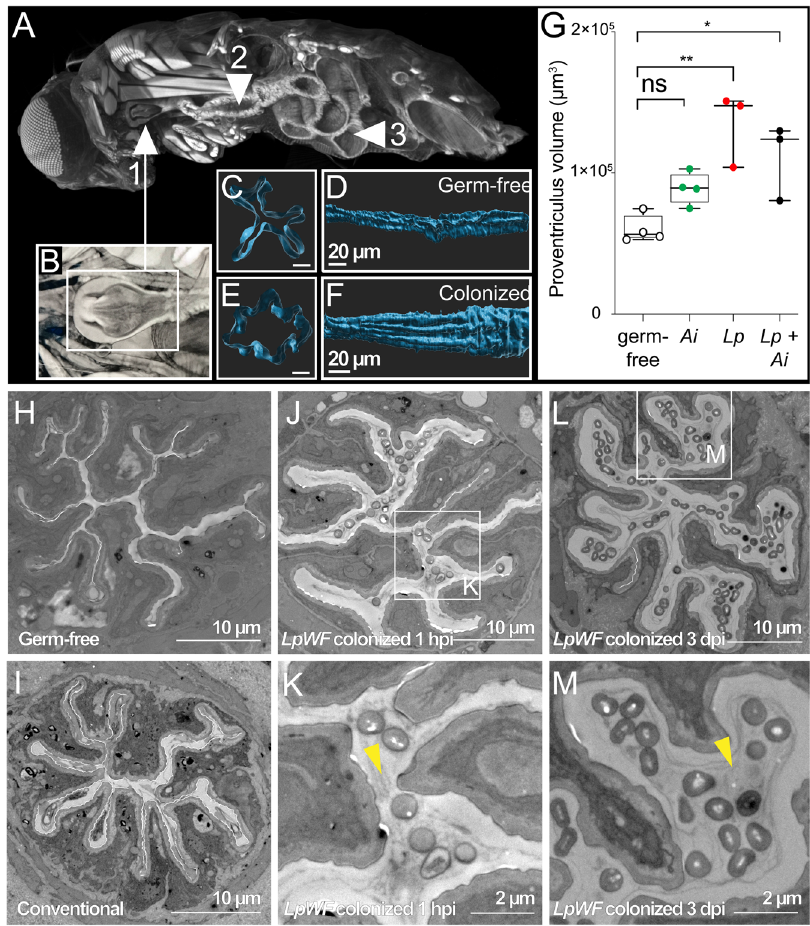
Fig. 4 | Colonization of the niche induces morphological alteration of the proventriculus. A Xray µ CT model of a whole fl y. Cutaway shows (1) exposed proventriculus (also inset of ( B )), (2) anterior midgut, and (3) posterior midgut. B Detail of proventriculus. C Cross-section of a germ-free proventriculus inner lumen.Scale bar:5 µ m. D Germ-freeproventriculusinnerlumen volumerendering. E LpWF -colonized proventriculus inner lumen cross-section. Scale bar: 5 µ m. F LpWF proventriculus innerlumen volume rendering. G Cardiavolume calculated from surface models ( n =3 to 4 fl ies per condition; p =0.0025, one-way